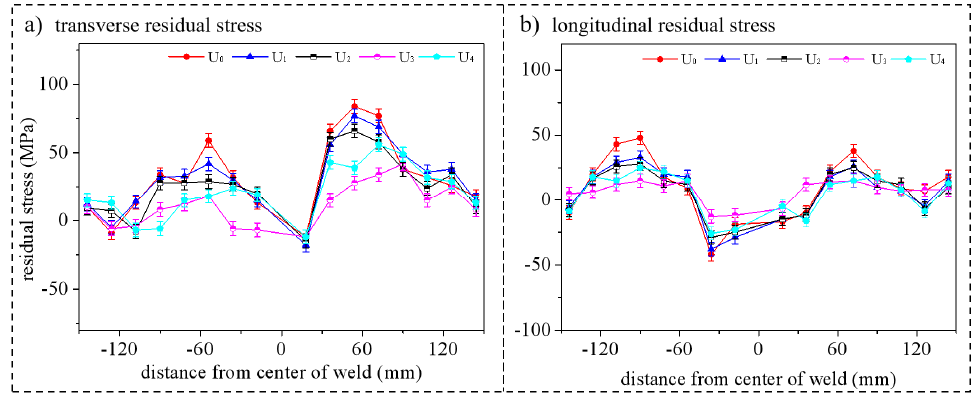
Figure 15. Comparison of surface residual stress along the pipe